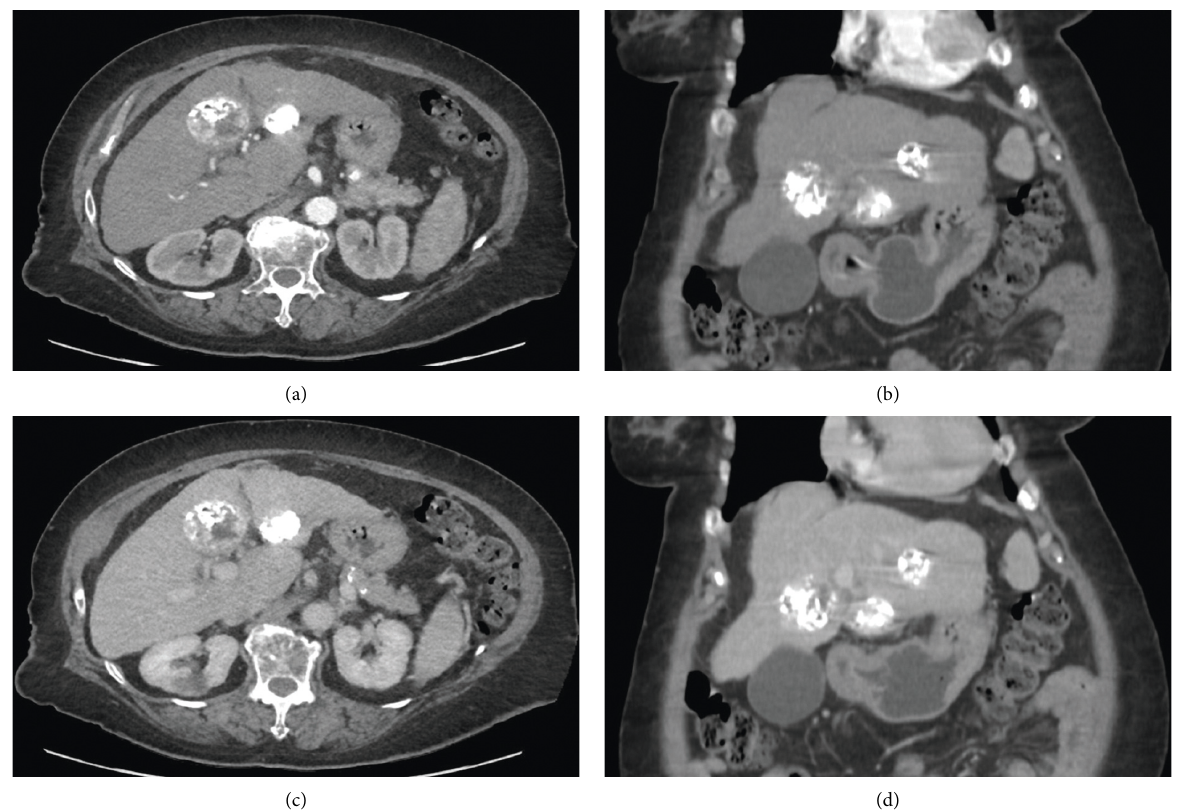
Figure 1: Abdominal computed tomography revealing a cirrhotic liver with 3 partial lipiodol-staining masses at left hepatic lobe with remaining viable part, size 3.7 × 2.9cm at segment III (viable part at anteroinferior aspect), 4.5 × 4.4cm at segment IVb (viable part at right posterolateral aspect), and 2.7 × 2.5cm at segment II (small viable part at posterior aspect) in axial and coronal view of arterial phase (a-b) and axial and coronal view of portovenous phase (c-d),